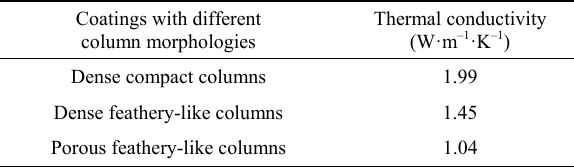
Table 6 Thermal conductivities of SPS TBCs with different column morphologies at 1200 ℃ [387] Coatings with different column morphologies